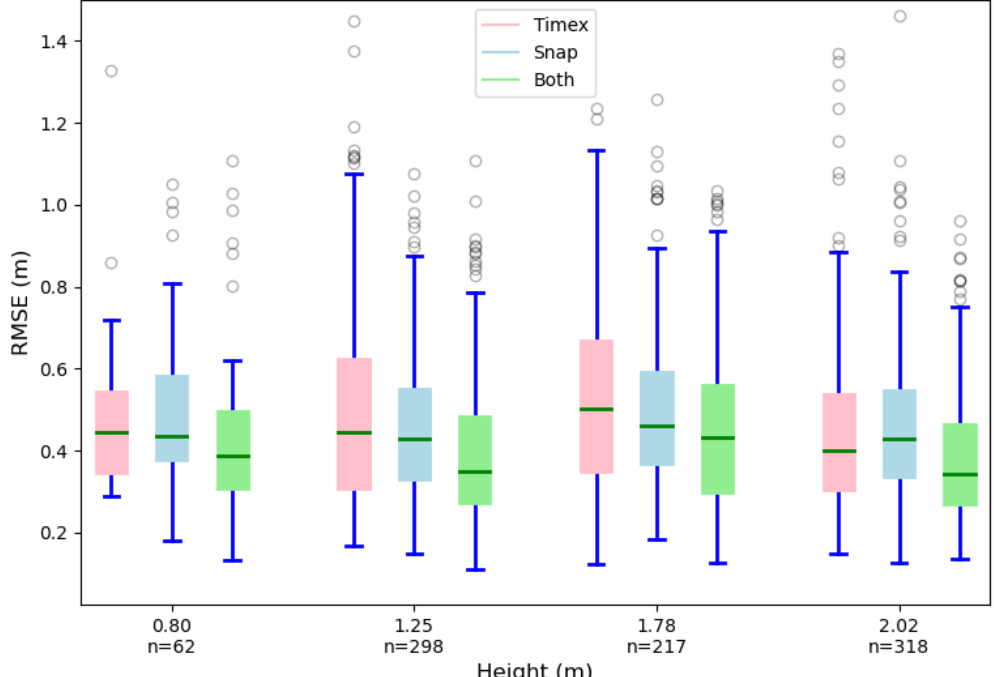
Figure 9. RMSE ( a ) and Bias ( b ) calculations as a function of binned offshore wave height values from the boundary of the Celeris model. The mean value of each set of bins is shown, as well as the number of images in each